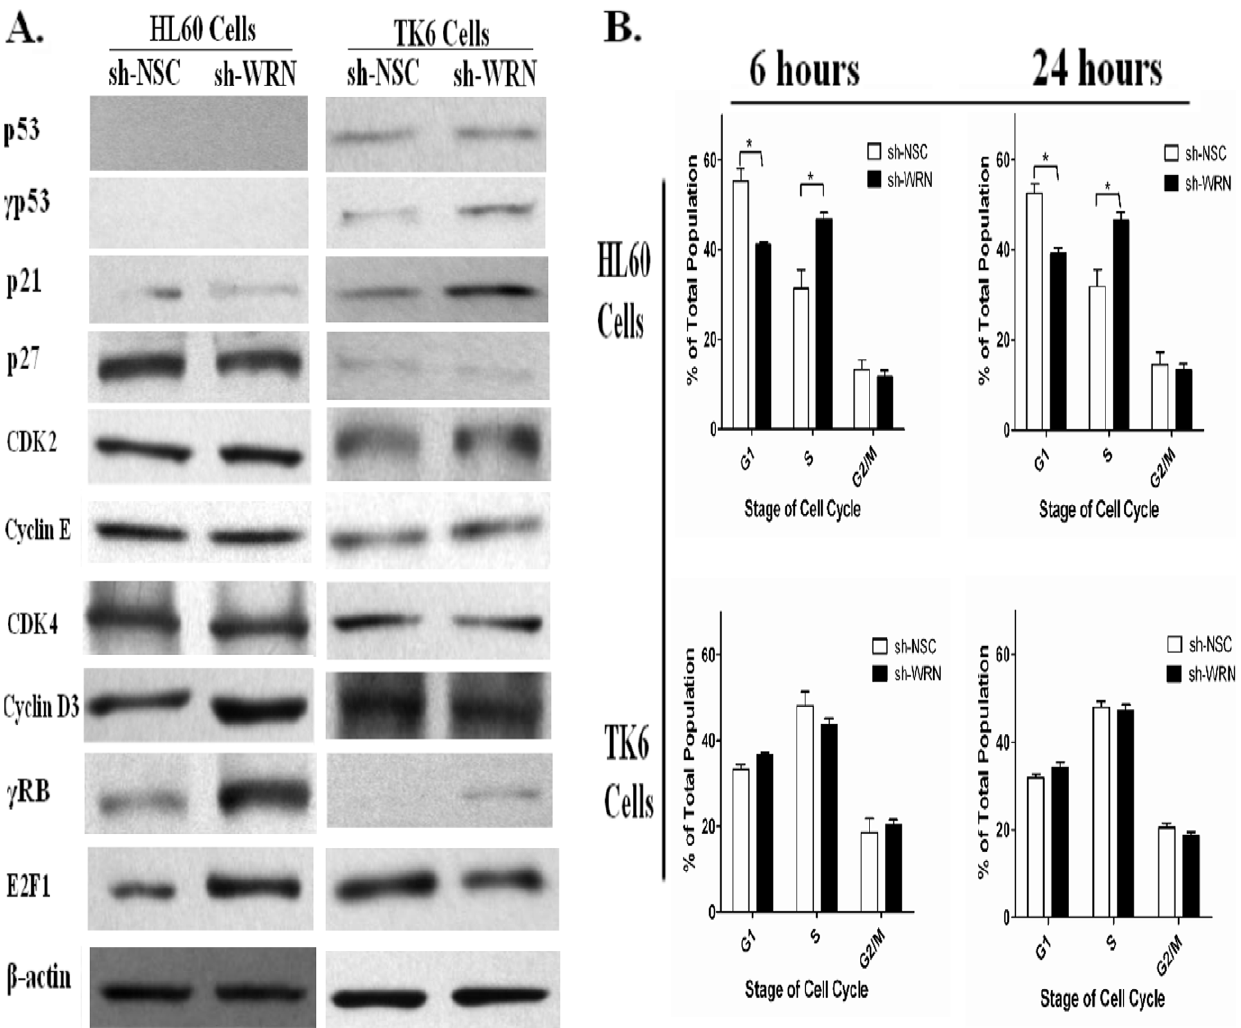
Figure 2. Silencing WRN increases c RB protein level and changes the cell replication rate in HL60 cells. (A) Total cell lysates from HL60 sh-WRN, HL60 sh-NSC, TK6 sh-WRN and TK6 sh-NSC cells were subjected to immunoblot analysis with indicated antibodies. Western blots are representative of three independent experiments. (B) Quantification analysis of the cell cycle distribution was performed by flow cytometric based methods. WRN loss increased the fraction of HL60 cells in S phase from 32% in HL60 sh-NSC cells to approximately 43% in HL60 sh-WRN cells across all time points. In contrast, the cell cycle distribution remained comparable between WRN deficient TK6 cells and control cells.